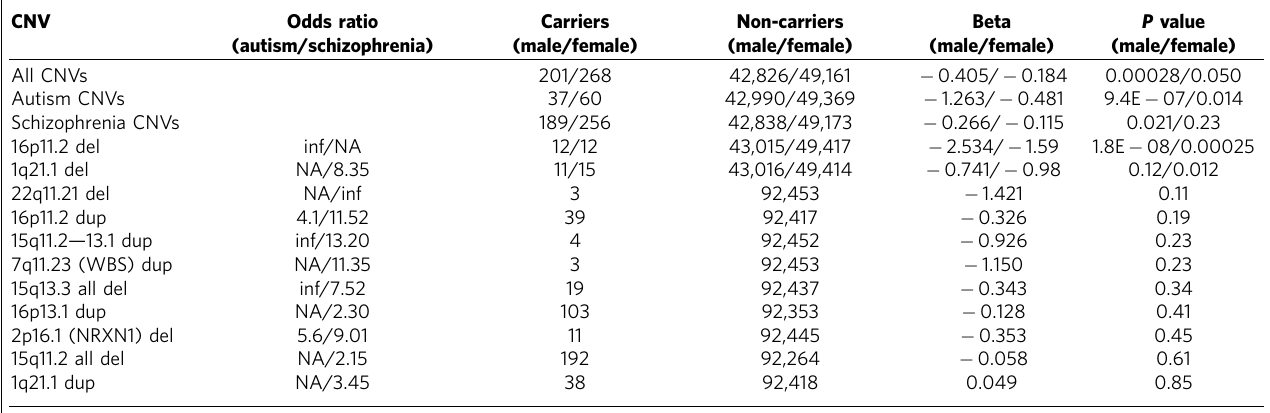
Resultsareshowninmalesandfemalesseparatelywhenthereisasignificant( P o 0.05)associationineithergroup.Countingallmodelsfitted,28testswereperformed;thusthe significancethresholdis P o 0.0017. Odds ratios for autism and schizophrenia are from the literature 7,8 .